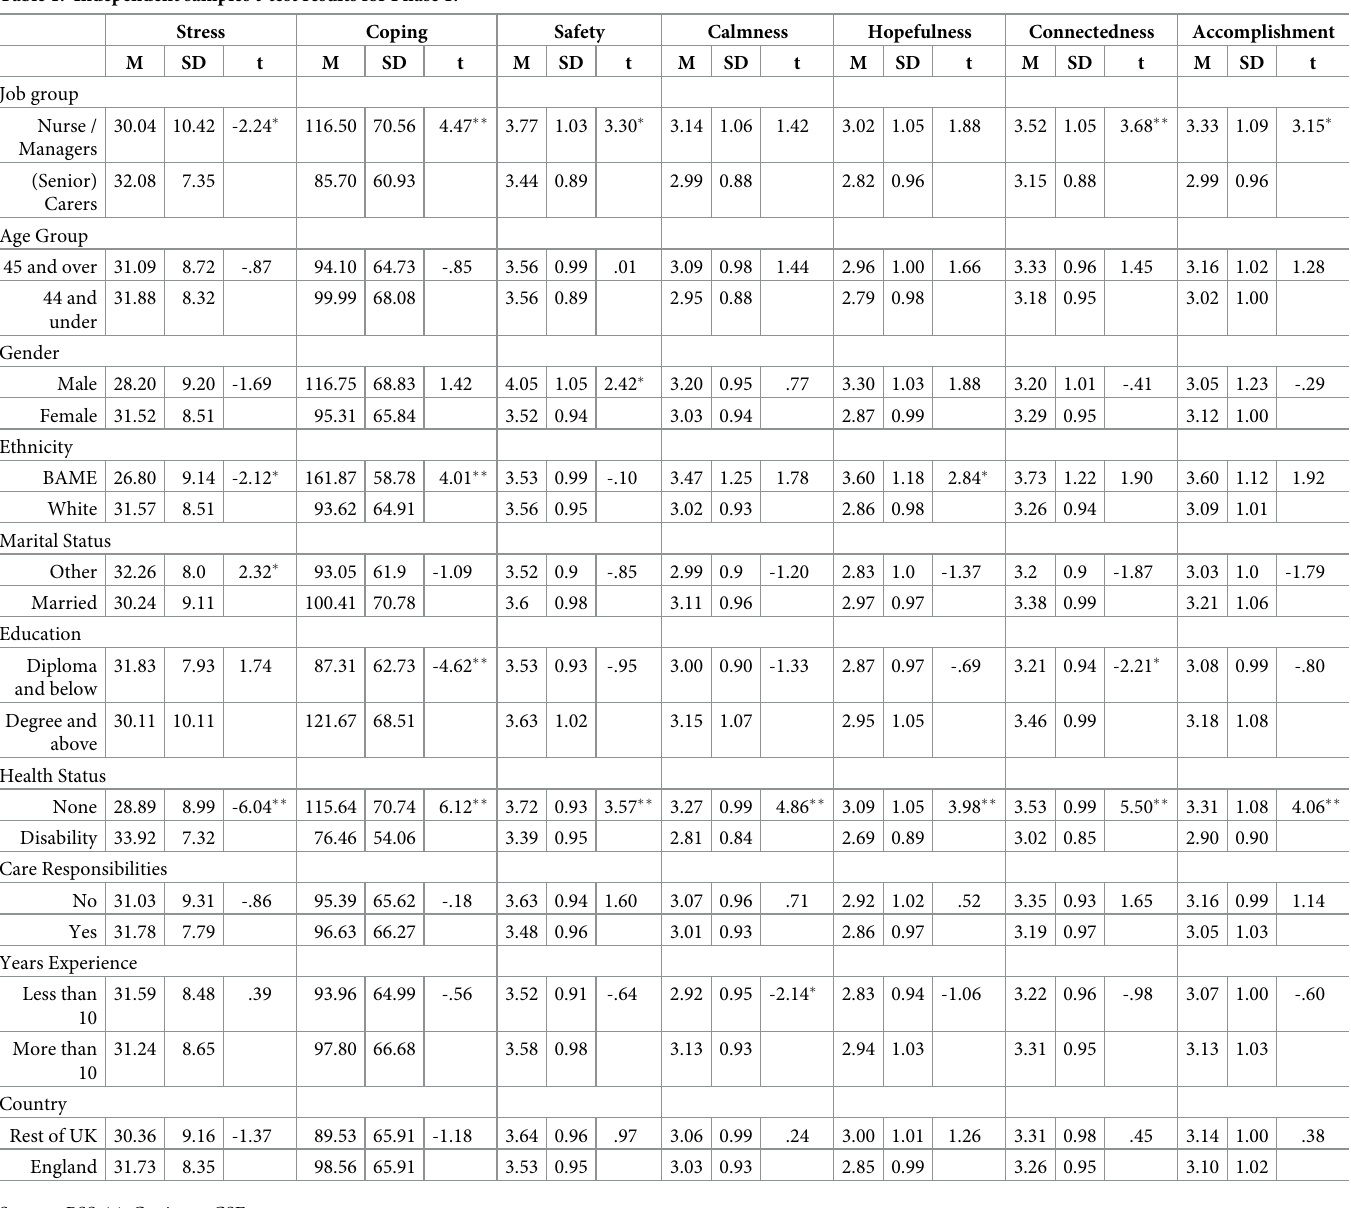
Table 1. Independent samples t-test results for Phase